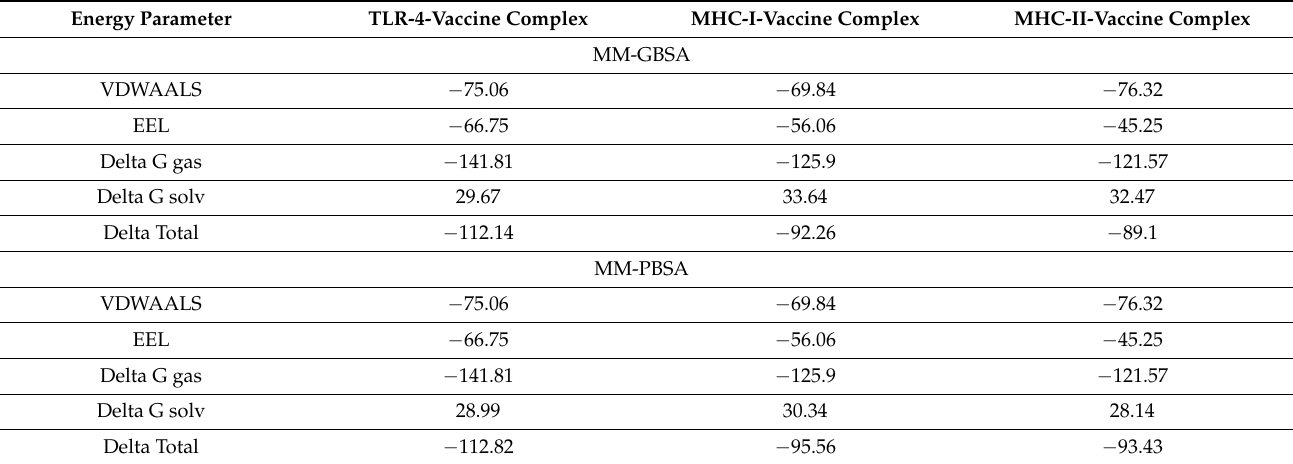
Table 6. MMGBSA/ PBSA binding free energies of the design vaccine with receptors.